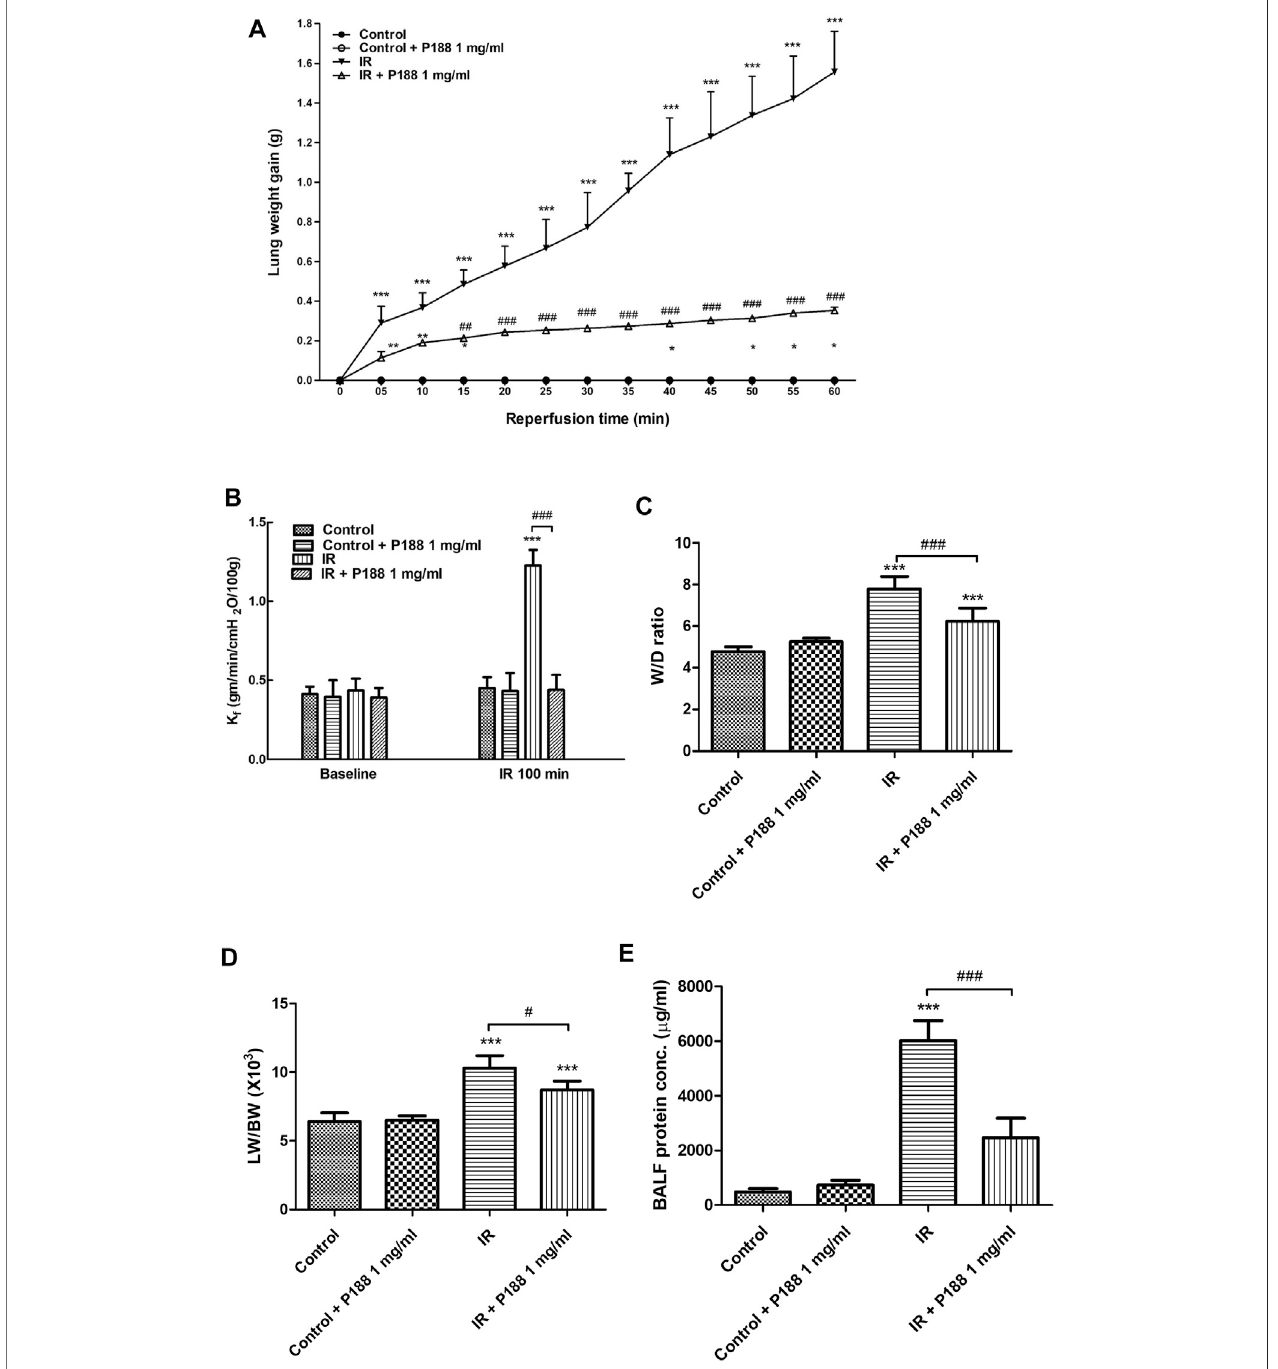
FIGURE1| EffectofP188onindicesofpulmonaryedema.Lungweightgainwasdeterminedcontinuouslyover60 minreperfusion (A) .K f (B) ,lungwetweight/dry weight (W/D) ratio (C) , lung weight/body weight (LW/BW) ratio (D) , and protein concentration in bronchoalveolar lavage fl uid (BALF) (E) were measured after 60 min reperfusion. Data are mean ± SD (6 rats per group); *** p < 0.001, compared with the control group; # p < 0.05, ## p < 0.01, ### p < 0.001, compared with the IR group.